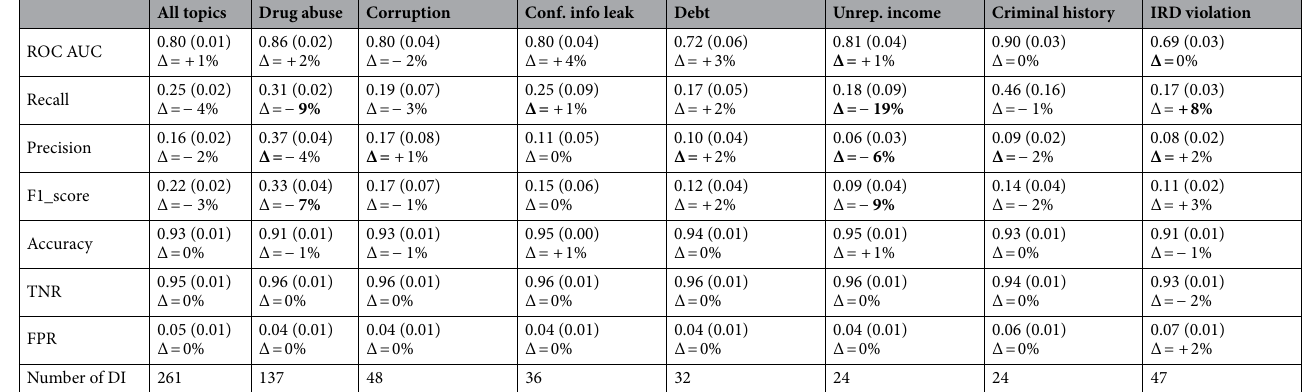
Table 6. A model built for “Drug abuse” topic inferences each of seven screening topics, measured using stratified K-fold cross-validation. Significant values are in bold.